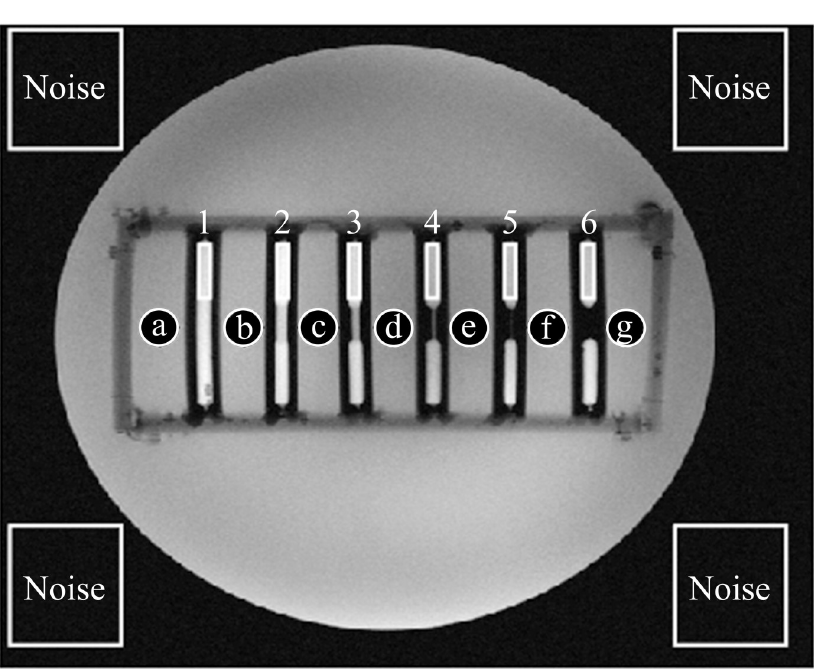
Fig 2. Signal-to-noise ratio (SNR) evaluation. Mean signal intensity was calculated by averaging the region of interest’s (ROI) pixels’ intensities (Gd-DOTA concentration 5.1 mM). Square ROIs were fitted into each of the contrast filled phantoms (1–6), circular ROIs were horizontally positioned in between the phantoms (a-g). Noise signal was drawn from the non-signal producing regions outside the phantom. B 1 -shimming and parallel transmission yielded an 18% higher SNR inside the stenosis phantoms and 47% for outside compared to the conventional single transmit